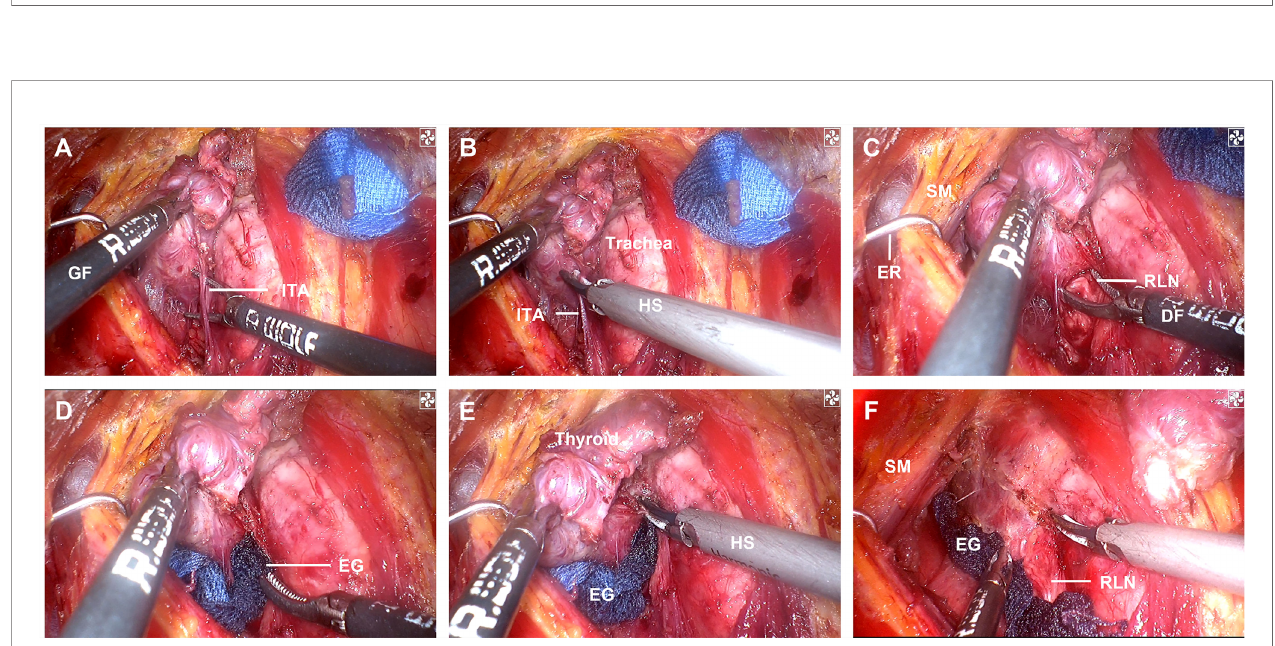
FIGURE 3 | Intraoperative nerve tunnel protecting (INTP) strategy was applied in open thyroidectomy. (A) Inferior pole of thyroid lobe was exposed, and the recurrent laryngeal nerve (RLN) was mapped by intraoperative neural monitoring (IONM) probe. (B) Expose one segment of RLN with clamps. (C) A tunnel was established along the direction of RLN with clamps. (D) Endoscopic gauze was stuffed in the tunnel and covered the surface of RLN. (E) Gauze protects RLN from thermal liquid – gas when harmonic scalpel (HS) was used to dissect non-neural tissues. (F) The “ tunnel ” was extended by a constant deepening of the gauze and gradually completed the separate pathway.